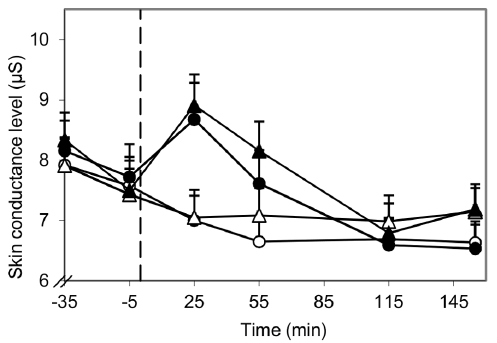
N Figure 5. Influence of ambiance and alcohol on skin conduc- 2 Pleasant, alcohol; 2 D 2 tance. 2 # 2 Pleasant, alcohol-free; 2 Unpleasant, alcohol-free; 2 m 2 Unpleasant, alcohol; - - start alcohol consumption (t=0). Skin conductance was higher 25 min after alcohol consumption compared to no alcohol consumption ( P , 0.001). Skin conductance decreased more from 25 min until 155 in the pleasant ambiance than in the unpleasant ambiance ( P =0.042). The values shown at time point 2 5, 25, 55 and 115 are averages of the mean skin conductance levels measured during three succeeding 2 min time